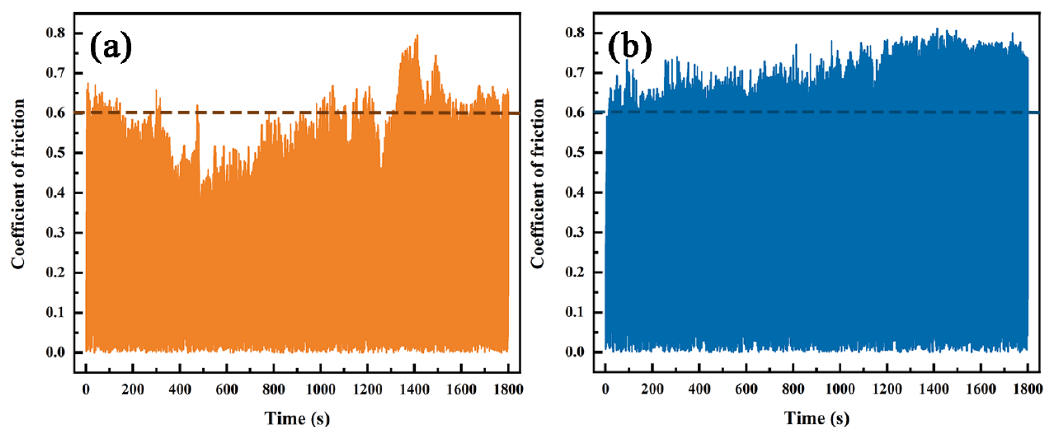
Figure 11. The friction coefficient curves of Inconel625 alloys coatings: ( a ) under UHSLC; ( b )under LSLC.